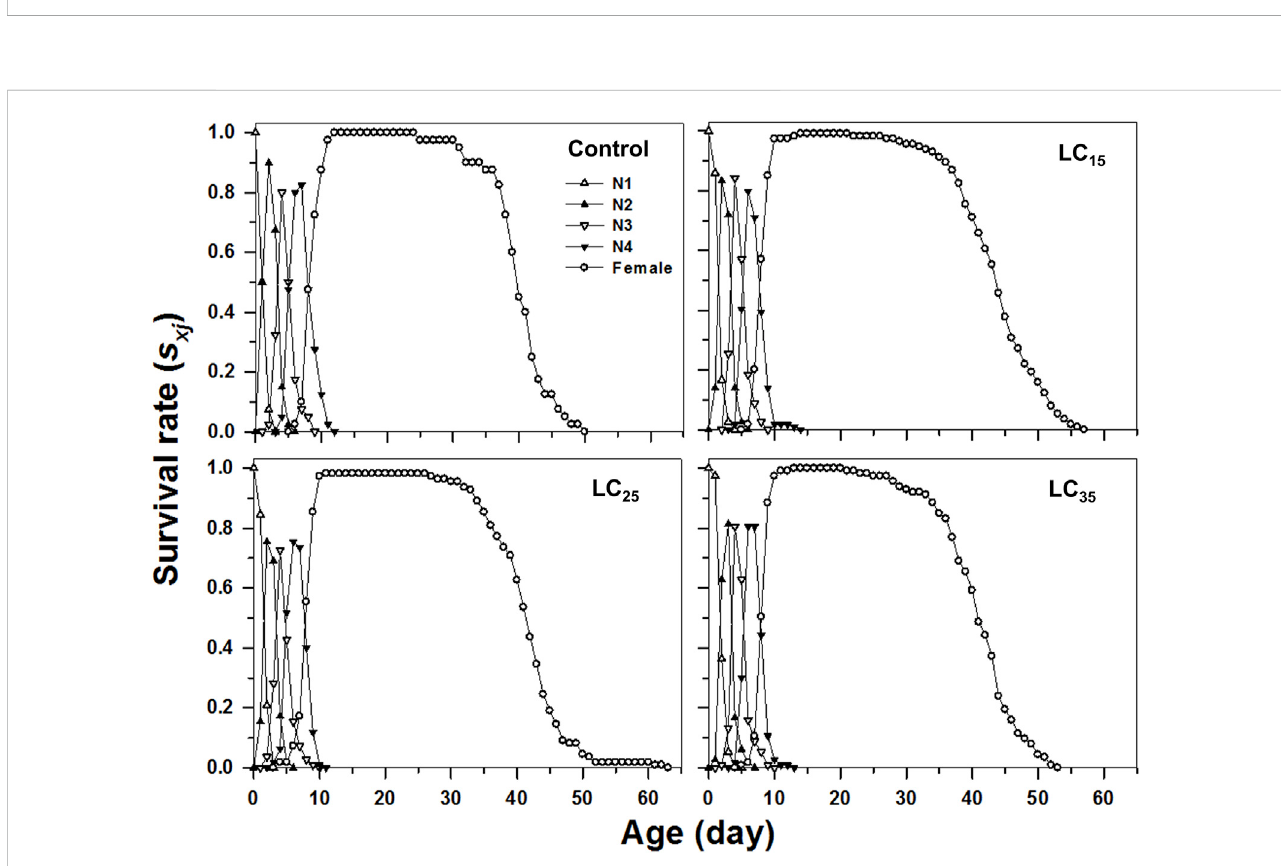
FIGURE 2 Age-stage-specifc survival rates ( s xj ) of Metopolophium dirhodum individuals of the F 1 generation under control conditions, treated with 50 mg/L of imidacloprid